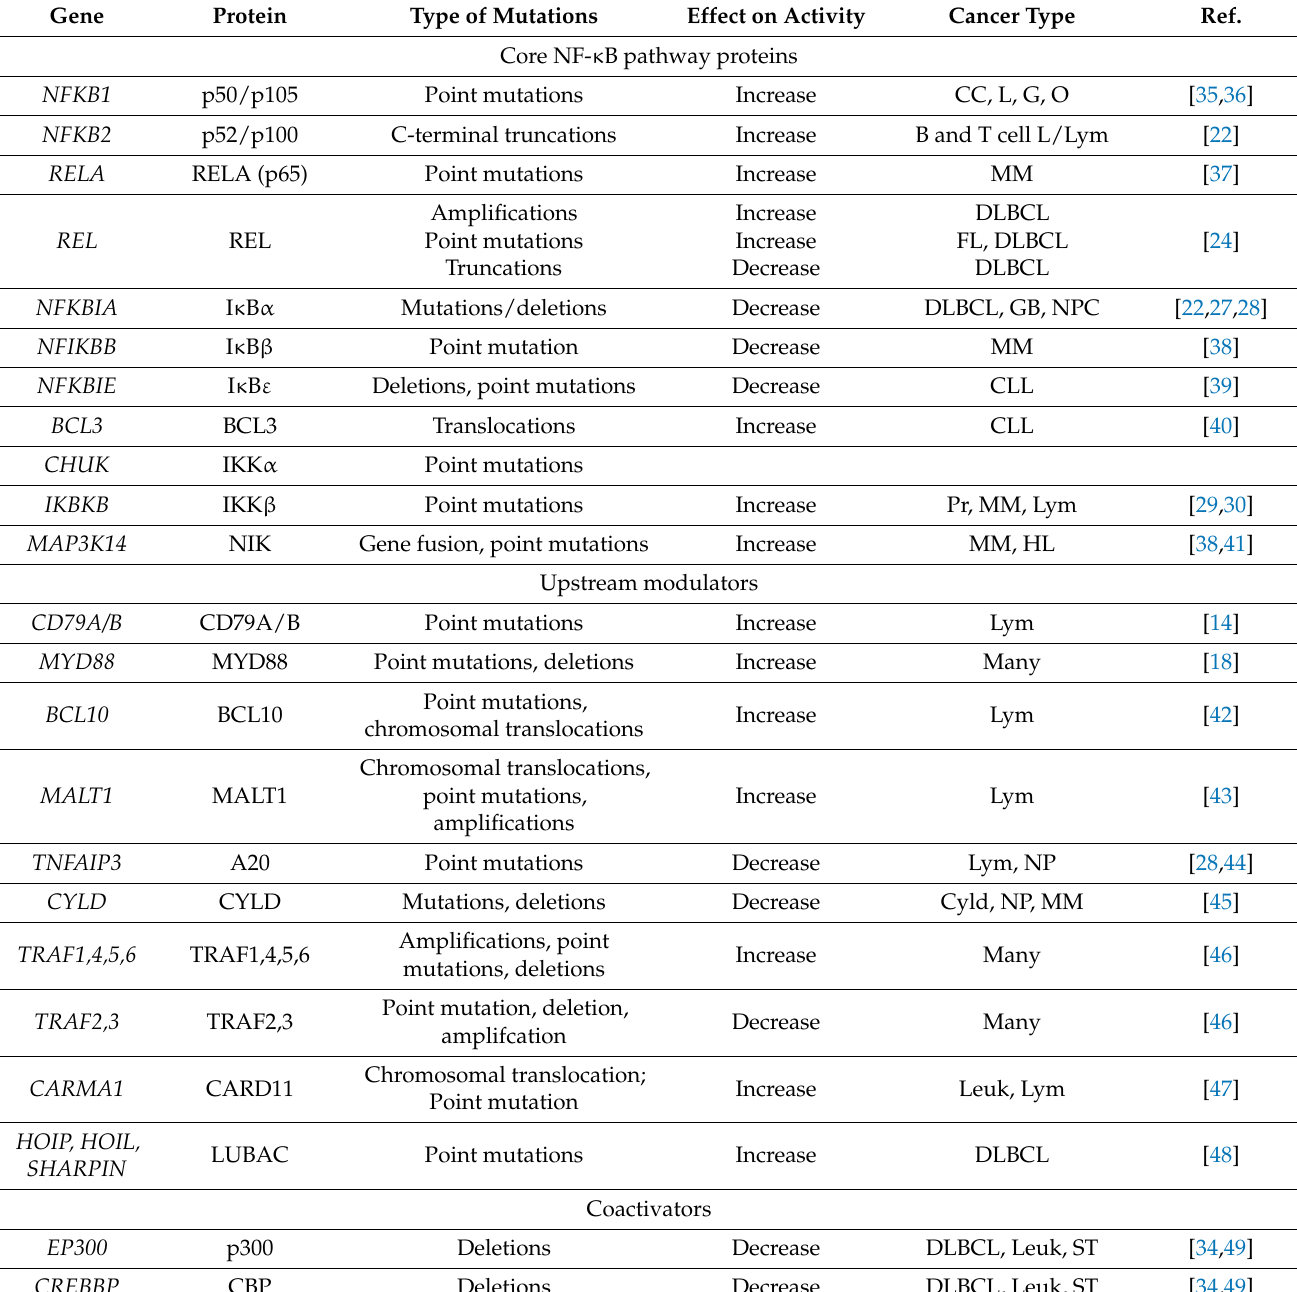
Table 2. Some mutations in the NF- κ B pathway in